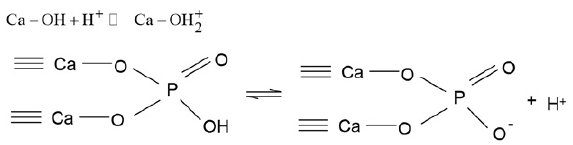
Figure 3. Dependence of adsorption process on the contact time.